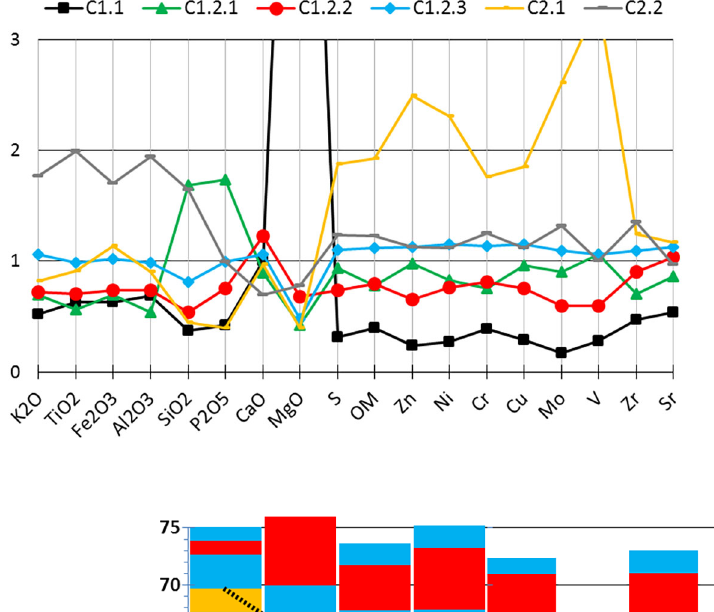
Fig. 7. Geochemical ‘patterns’ of different